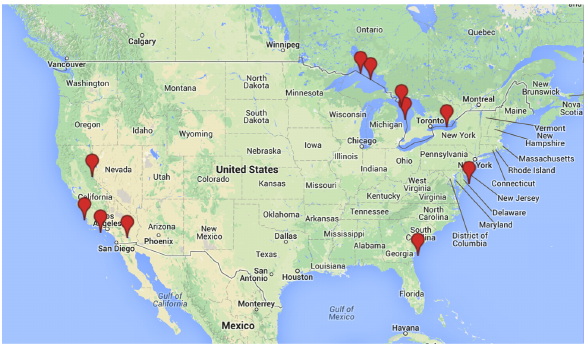
Figure 1: Distribution of validation sites throughout the United States.